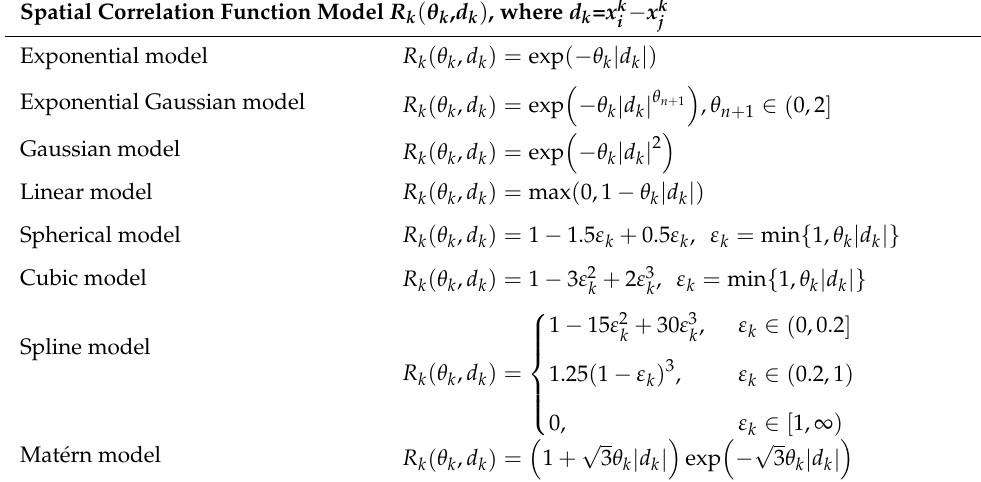
Table 1. Expressions of different correlation functions.